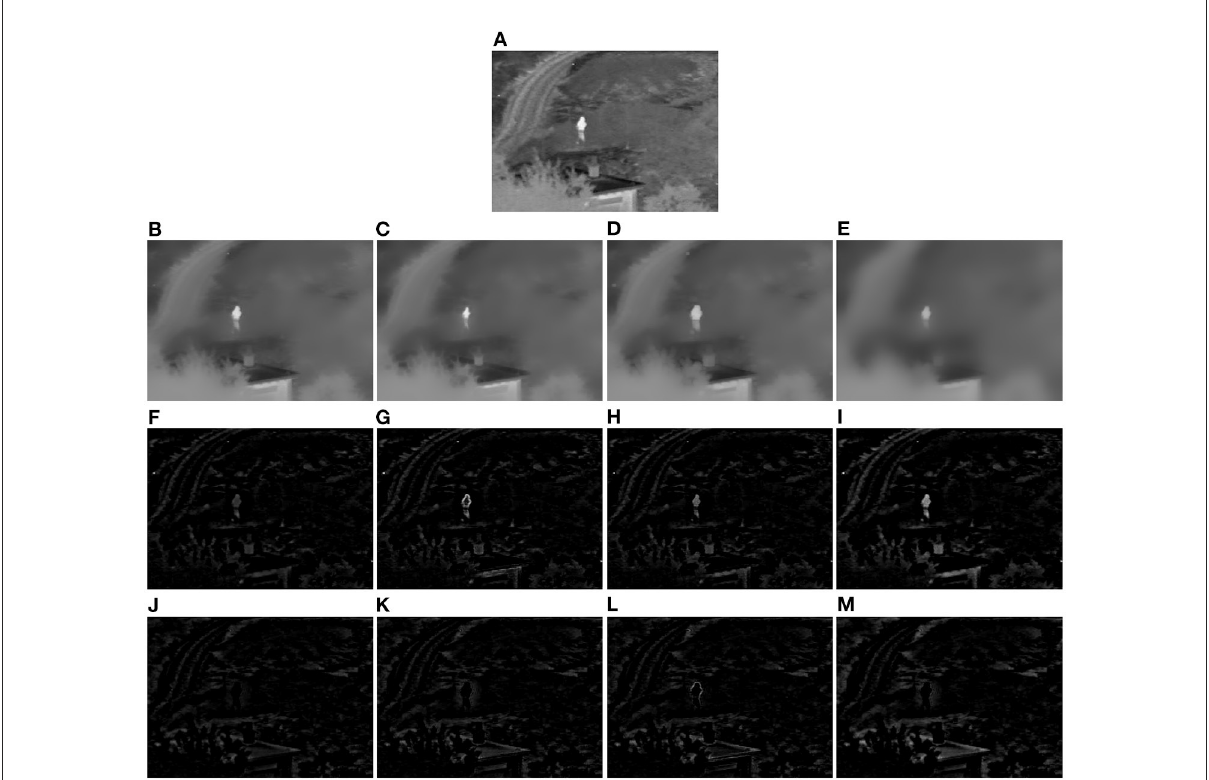
FIGURE2 Demonstration example of the local extreme map guided image filter (Toet, 2017). (A) Original infrared image. (B) Image smoothed by the image filter guided by the input image itself. (C) Image smoothed by single local minimum map guided image filter. (D) Image smoothed by single local maximum map guided image filter. (E) Image smoothed by our local extreme map guided image filter. (F–I) Bright feature maps extracted from the difference images of (B–E) and (A) , respectively. (J–M) Dark feature maps extracted from the difference images of (B–E) and (A) , respectively (Note that the dark feature maps in this figure have been illustrated as their absolute feature maps in order to properly visualize the dark features).